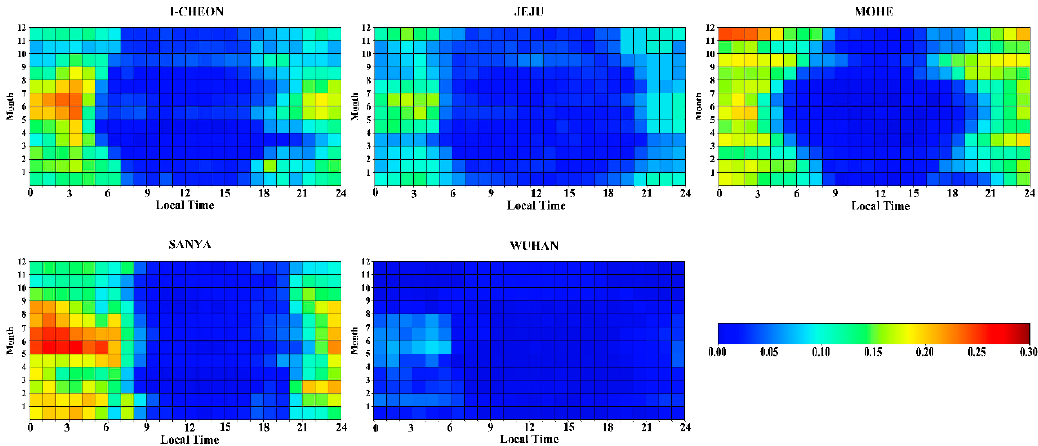
Figure 4. Occurrence rate of SF at Mohe, I ‐ Cheon, Jeju, Wuhan, and Sanya according to the 0–24 LT and January–December division.